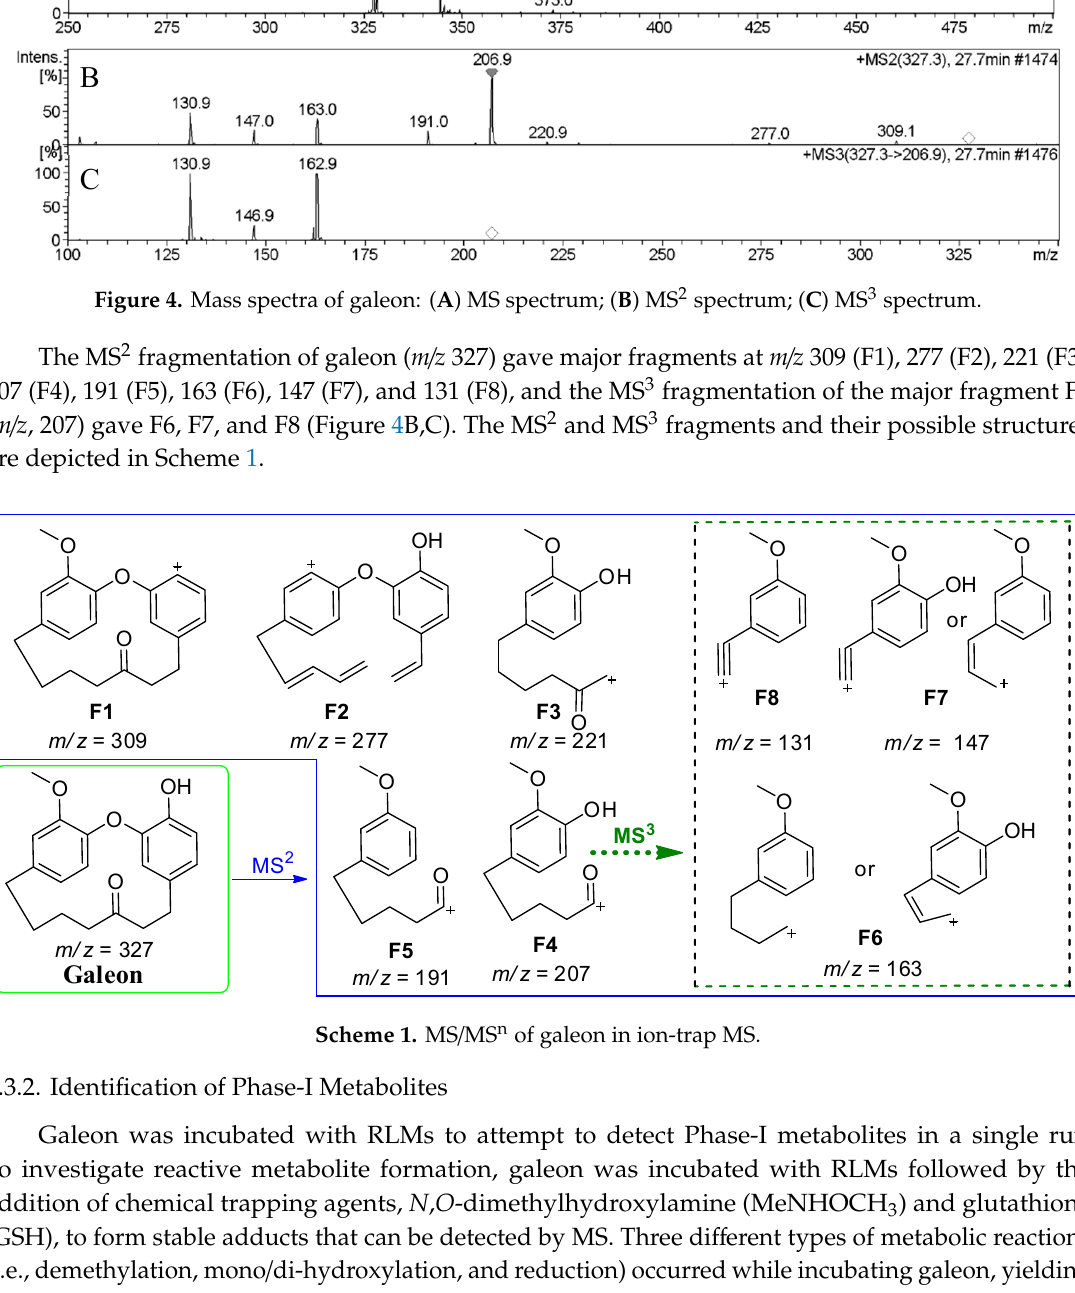
Table 2. Possible Phase-I metabolites of galeon.